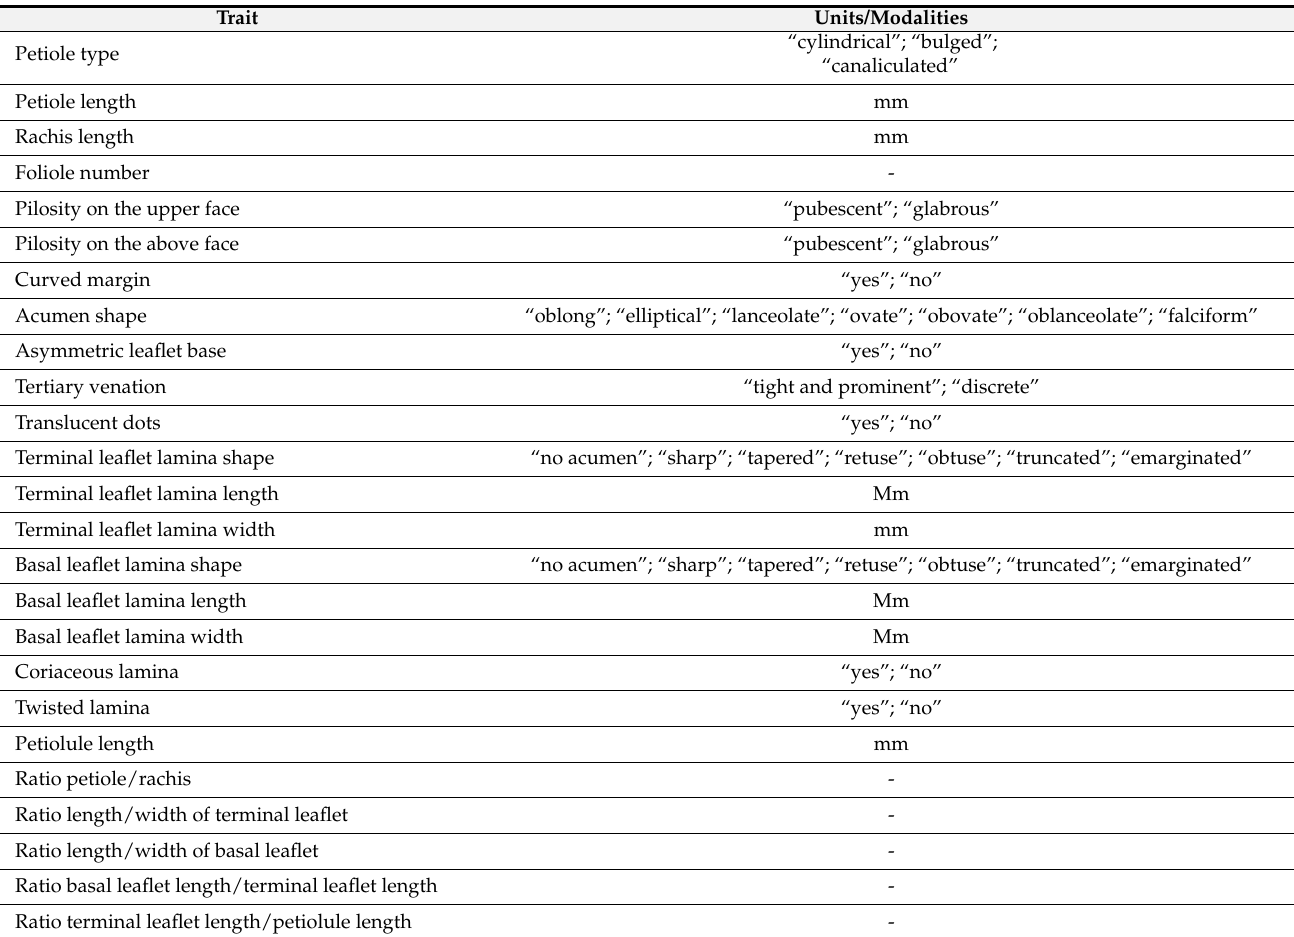
Figure 1. Field herbarium examples of Dialium pachyphullum Harms ( a ), Dialium sp. nov. ( b ) and Dialium lopense Breteler ( c ). Table 1. Leaf morphological traits